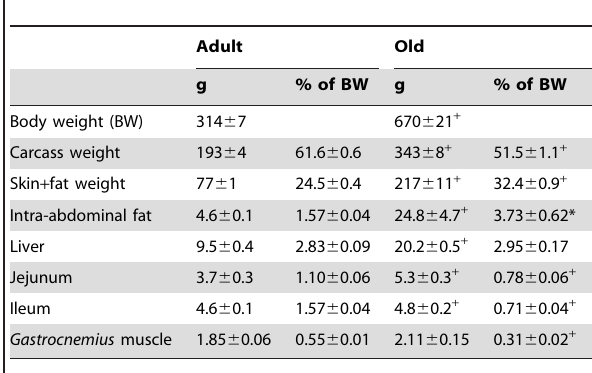
Table 3. Effect of age on body